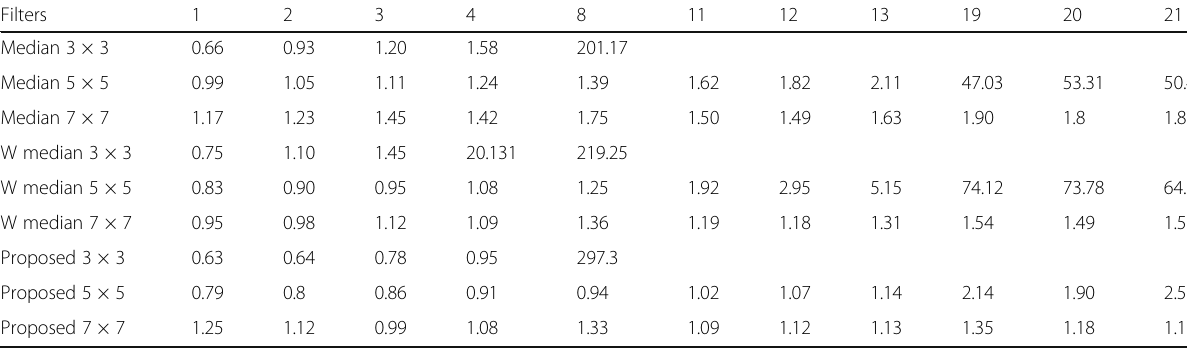
Table 2 Average MSE (× 10 3 ) comparison for different nos. of noisy pixels